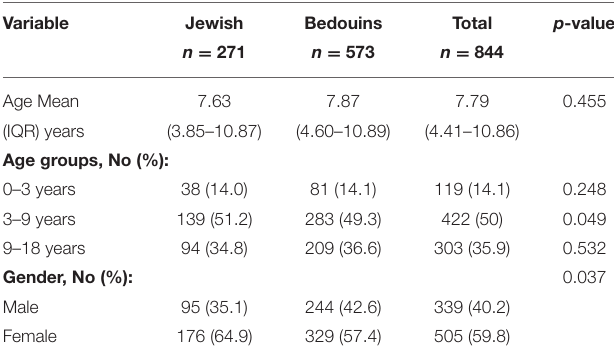
TABLE 1 | A comparison of demographic characteristics between Jewish and Bedouin